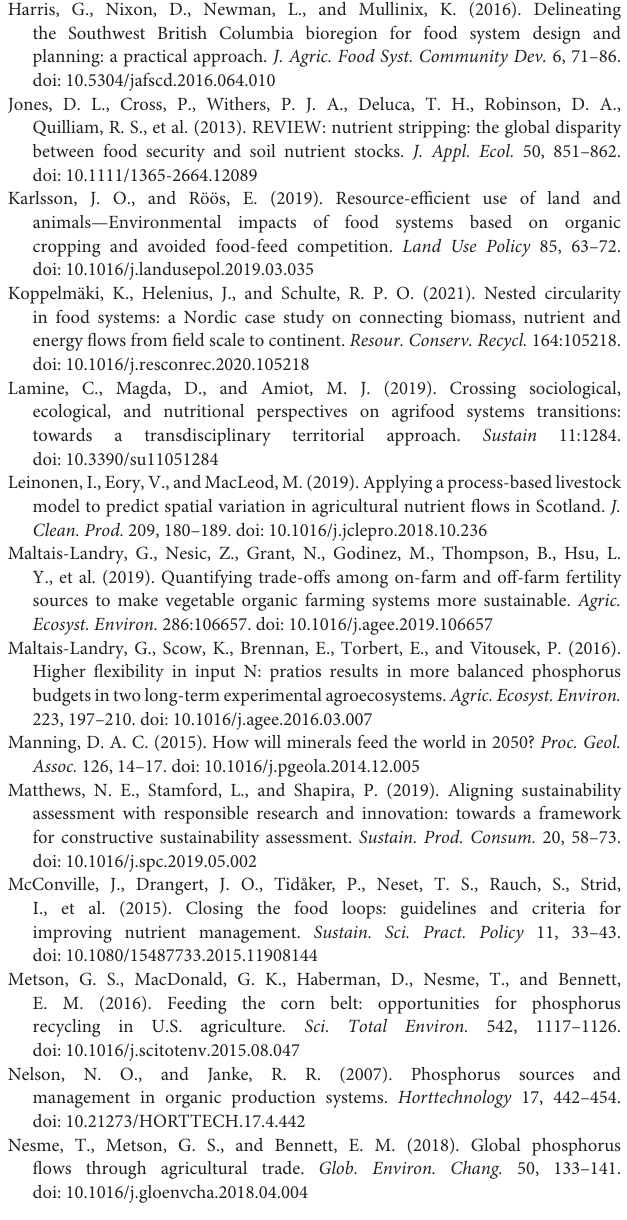
Supplementary Material 2 | Spreadsheet model used for